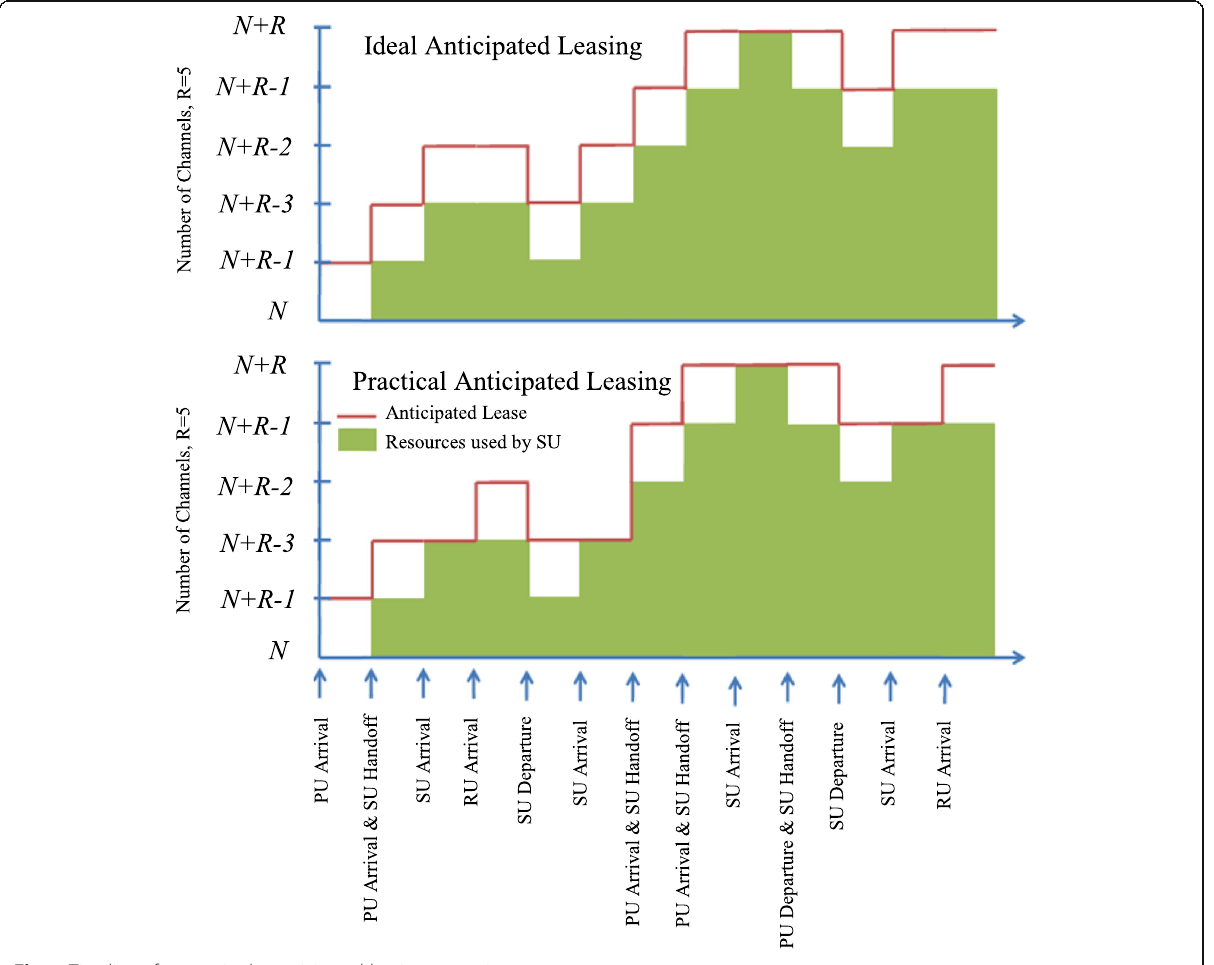
Fig. 4 Timeline of events in the anticipated leasing